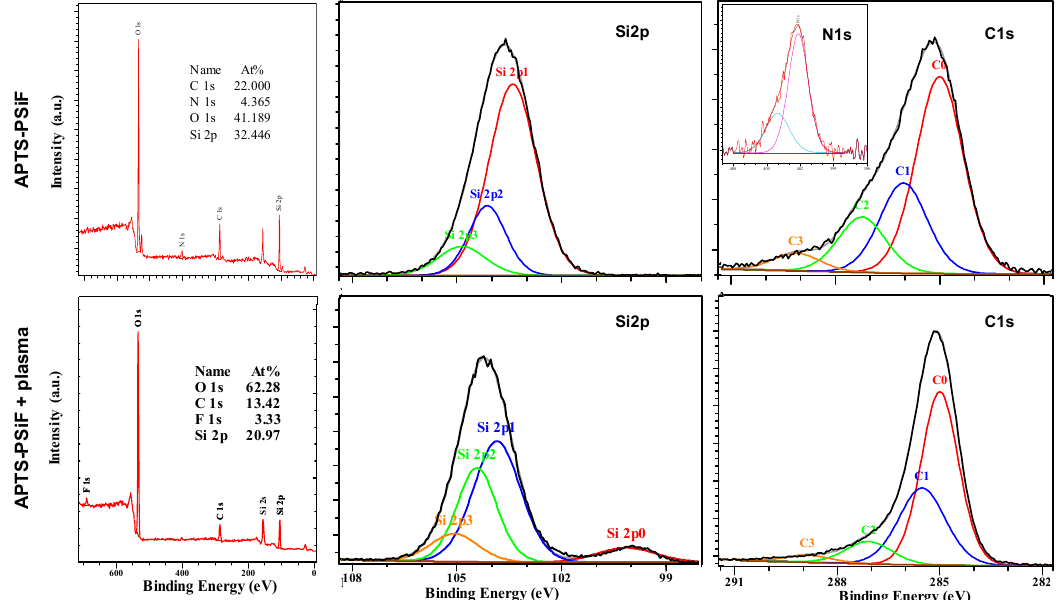
Figure 3. X-ray photoelectron spectroscopy (XPS) analysis of an APTS functionalized PSiF before ( top ) and after ( bottom ) an Ar plasma etching process. From left to right: widescan, Si2p and C1s spectra. Note: N1s inset to the fresh APTS-PSiF sample.